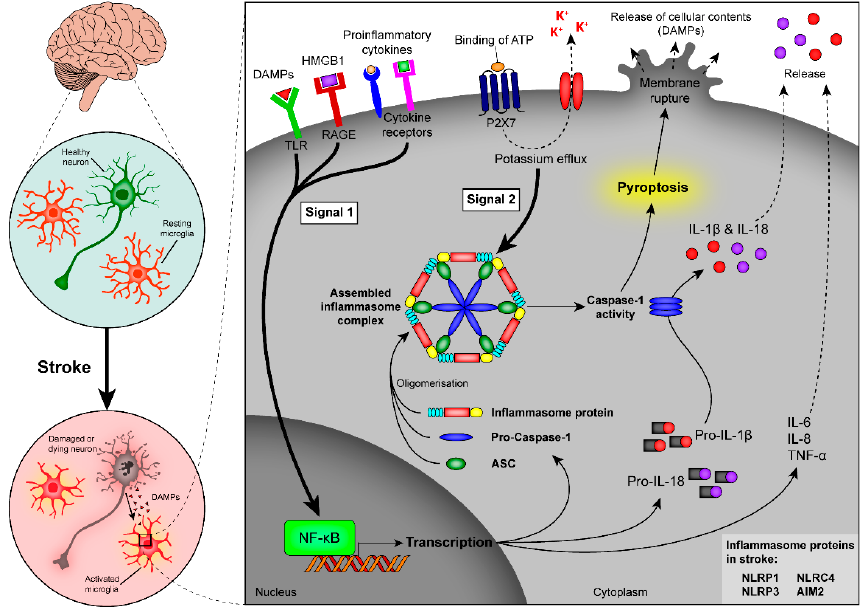
Figure 3. Induction of inflammasome activity and pyroptosis after stroke. Signalling through PRRs results in NF- κ B activation, which is associated with up-regulated transcription of inflammasome components (inflammasome proteins, pro-caspase-1, and ASC) and the immature cytokines pro-IL-1 β and pro-IL-18, as well as an increased production of pro-inflammatory cytokines, such as IL-6, IL-8, and TNF- α ( signal 1, bold arrow ). A second signal ( signal 2, bold arrow ) leads to oligomerisation of the inflammasome components and activates the inflammasome complex. Signal 2 can, for example, occur through binding of ATP to its P2X7 receptor. As a result of inflammasome assembly and activation, caspase-1 gets activated and cleaves the inactive cytokines pro-IL-1 β and pro-IL-18 to their active form, which are released from the cell (dashed arrows). Caspase-1 is also an important mediator of pyroptosis, a highly-inflammatory form of cell death, which results in the swelling and bursting of cells with the subsequent release of cell content into the extracellular space. PRRs, pattern recognition receptors; NF- κ B, nuclear factor kappa B; ASC, apoptosis-associated speck-like protein containing a CARD; IL, interleukin; tumour necrosis factor- α ; ATP, adenosine triphosphate.